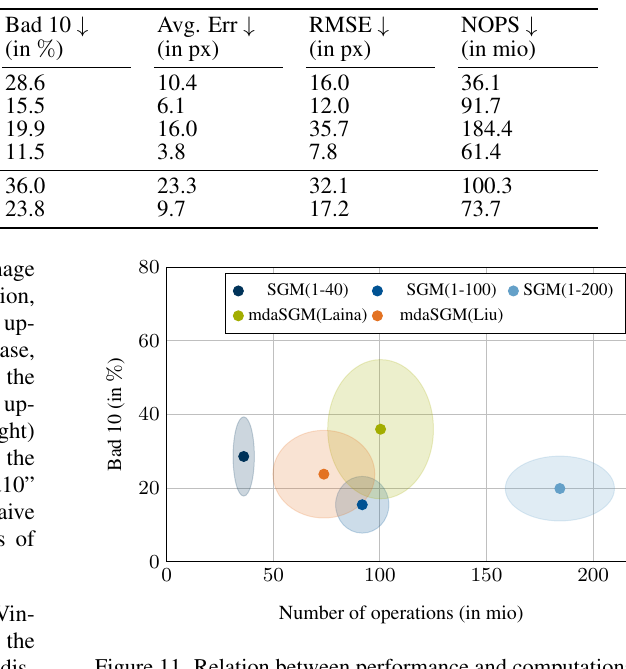
minute, versus over three minutes for standard, overestimated